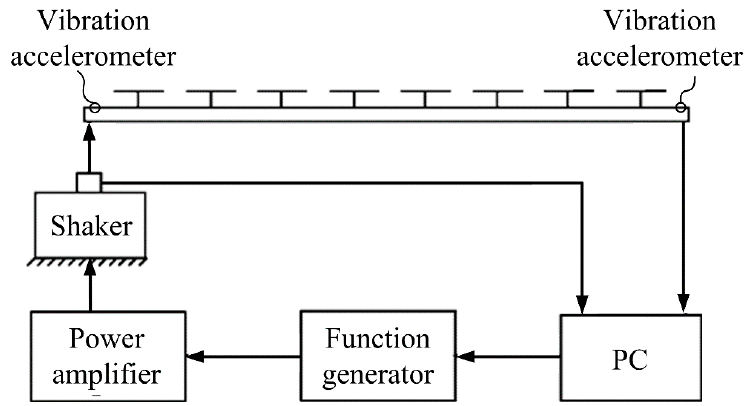
Figure 9. Experimental setup for measuring the input and output accelerations near the two ends of the host beam.